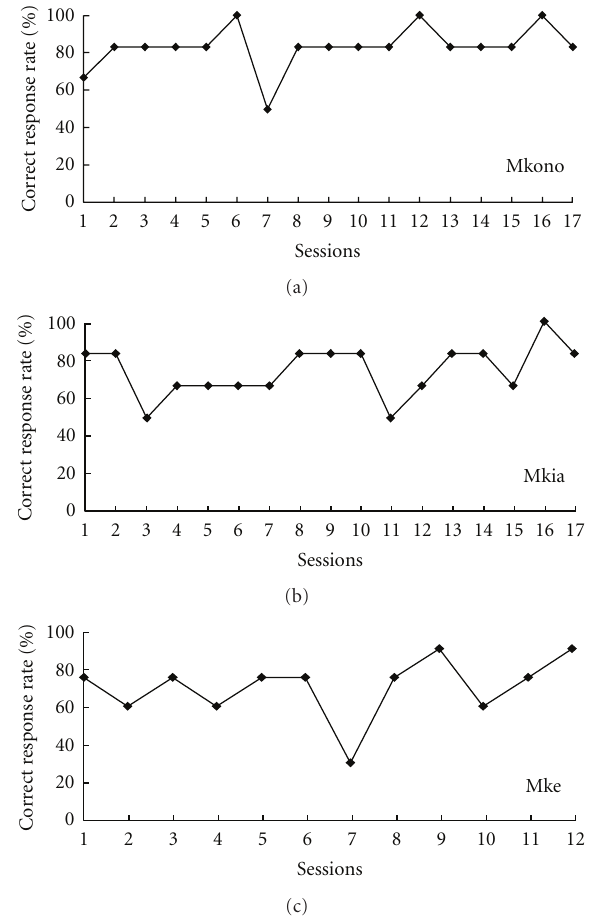
Figure 5: Correct response rates over sessions for one-step subtrac- tion. The correct response rates were calculated as the percentage of “attempt made” trials when the remainder was 2 and 1, and “attempt not made” trials when the remainder was 0, over the total 6 trials for each session for each